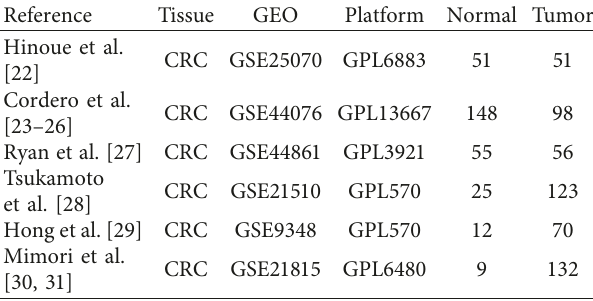
Table 2: Detailed information on the six microarrays from the GEO database.